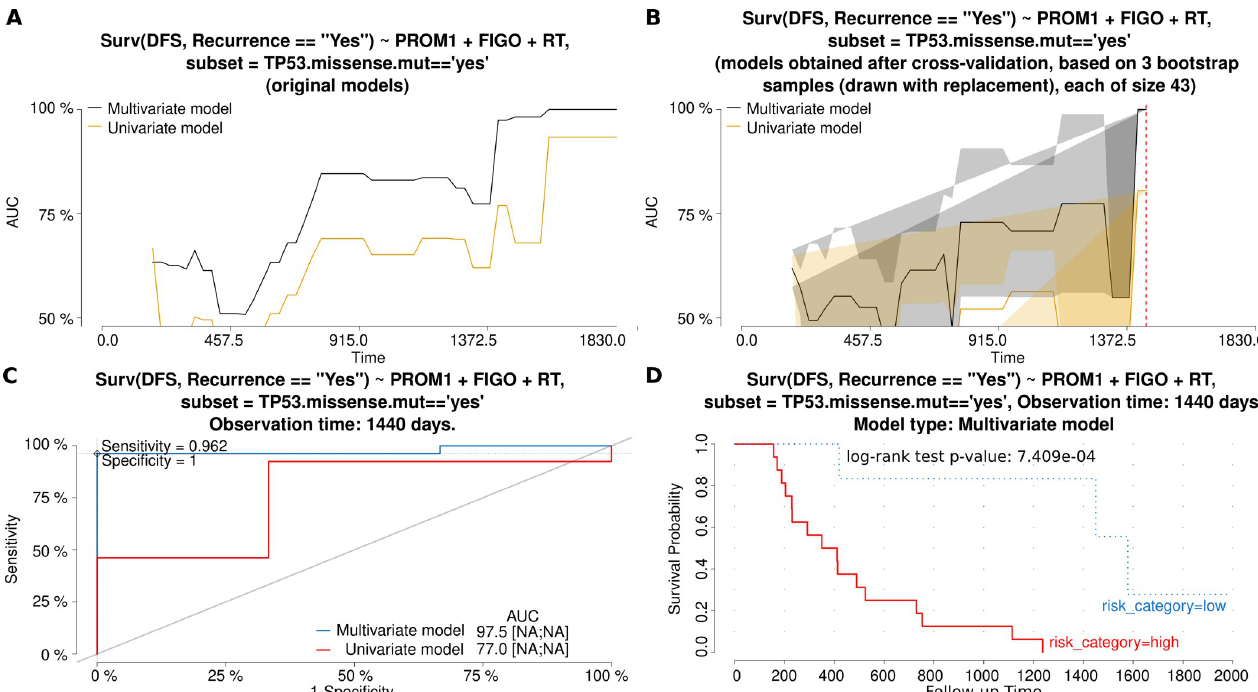
Fig 1. Characteristics and comparison of the Cox regression models (gene: PROM1 ). The models allowed for the assessment of the risk of recurrence , depending on either a single independent variable ( PROM1 mRNA expression (exp)–the univariate model or three independent variables (exp, FIGO and RT)–the multivariate model. Fig A and B show how the AUC values (and thus also discriminating abilities of each model) change in time for original models (A) and models obtained after a bootstrap-based cross-validation of the original data set (B). The bigger the AUC, the higher the performance of a model. A red dashed line marks the same time point which was used to draw the time-dependent ROC curve (C) for both models. In Fig C, an optimal cut-off point was calculated for the multivariate model based on the Youden index. Sensitivity and specificity for this cut-off point are also provided. In addition, AUC values [%] are listed alongside the 95% CI values, shown in square brackets, if calculable. Fig D depicts the Kaplan-Meier survival curves obtained for the multivariate model at the same time point as in the remaining plots. The risk was classified as either higher (high) or lower (low) than in the cut-off point. The Kaplan- Meier curves are supplemented with the result of the log-rank test, as well. Abbreviations used: DFS–Disease-Free Survival, FIGO–clinical stage; RT–Residual Tumor.